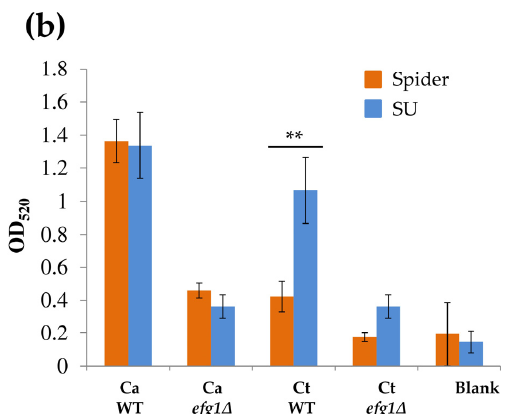
Figure 3. Quantitation of biofilms of C. albicans and C. tropicalis wild ‐ type (WT) and efg1 Δ strains in the Spider and SU biofilm formation conditions: ( a ) The use of SU medium resulted in increased C. tropicalis biofilm formation , whereas C. albicans showed a similar biomass when cultured with Spider medium and SU. Representative images of biofilm formation were shown below. ( b ) The extent of C. albicans and C. tropicalis biofilms were measured using crystal violet and resulted in similar conclusions in Figure 3a. Values are the mean ± SD from four replicates. ** p < 0.01. The C. albicans efg1 Δ and C. tropicalis efg1 Δ strains were used as negative controls.